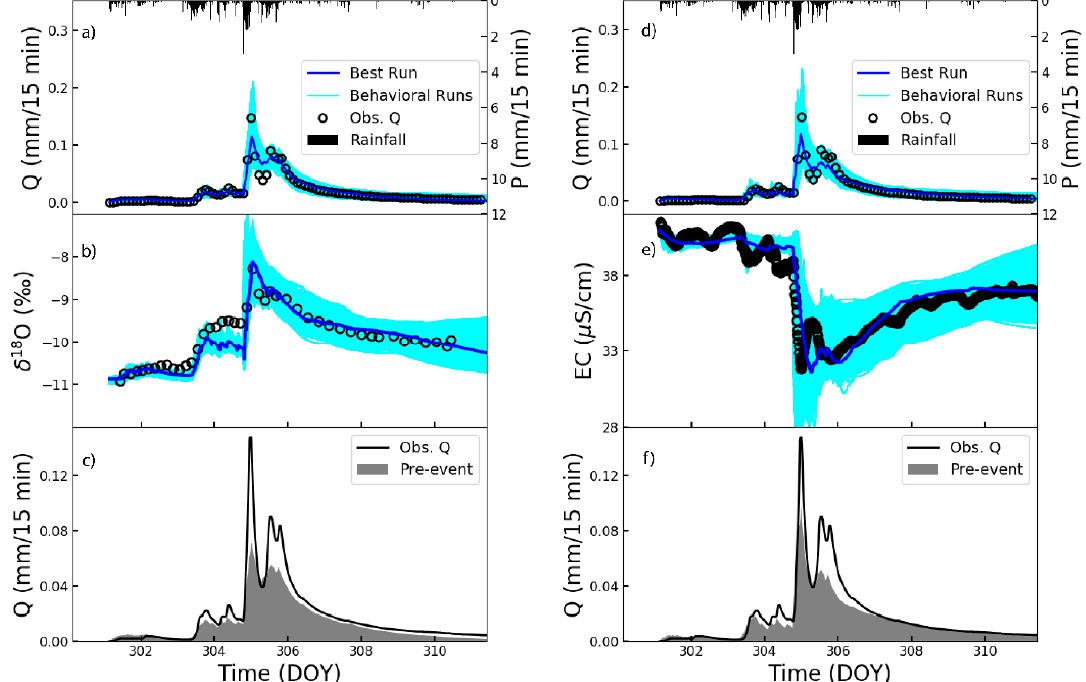
Figure 5. TraSPAN model results of the hydrograph separation using structure 4 calibrated with δ 18 O ( a – c ) and electrical conductivity (EC) ( d – f ) as tracers. ( a , b , d , and e ) present observed (open markers) and simulated streamflow and tracer data according to all parameter sets (blue lines) that yield a Nash-Sutcliffe coefficient above 0.75 (behavioral parameter sets). The best simulated times series in both cases are depicted in dark blue lines. ( c and f ) present the pre-event water (gray area) and the event water (white area) contributions during the storm, according to the best set of parameters.